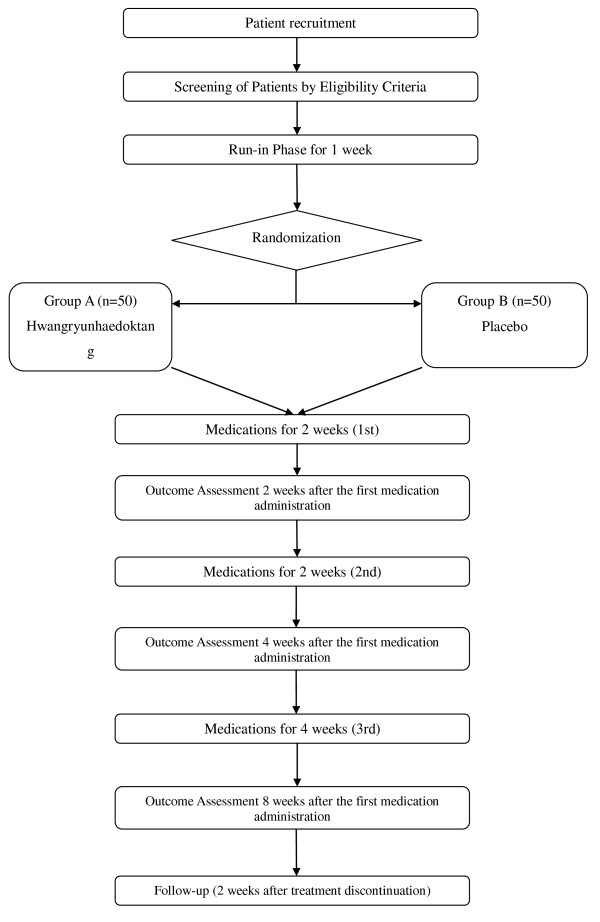
Study Flow Chart.